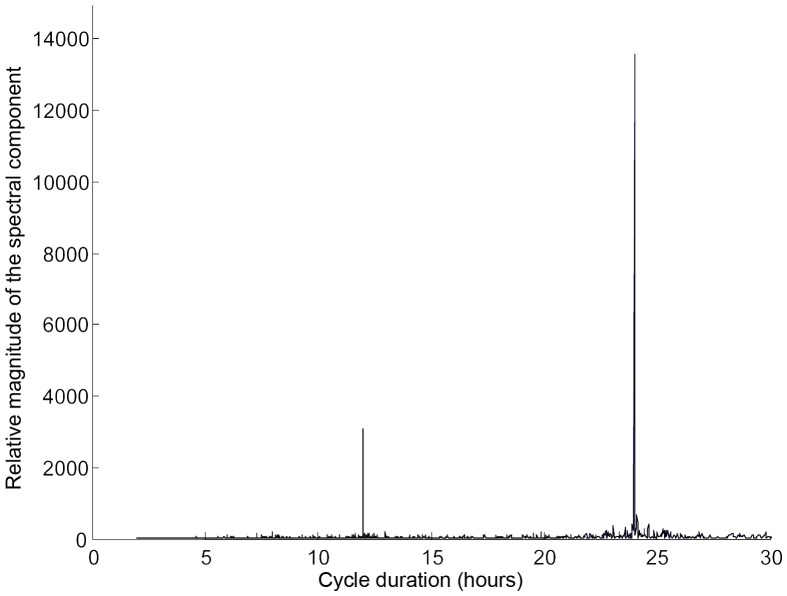
Fast-Fourier transformation of hourly detection frequencies of a grey reef shark in Palau.Diel patterns of corrected detection frequencies are represented as peaks of relative magnitude of spectral component. The transformation shows the diel periodicity of detection frequencies of a female grey reef shark (no. 53366, LT = 144 cm), a representative example of diel cycles of detection frequencies of the sharks tagged in Palau.